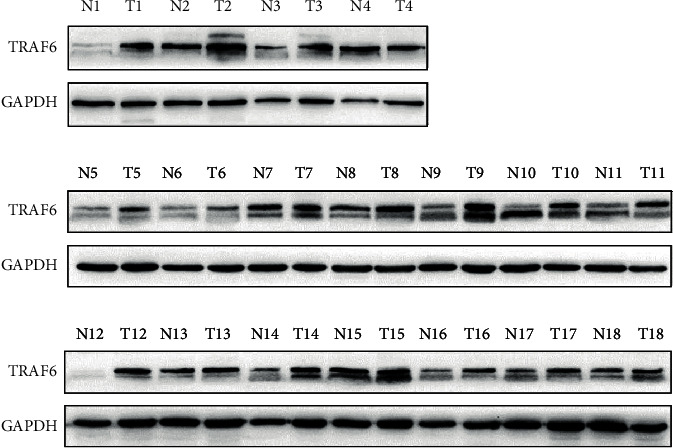
Western blot assay of TRAF6 protein levels in gastric cancer (T) and paired adjacent (N) tissues.